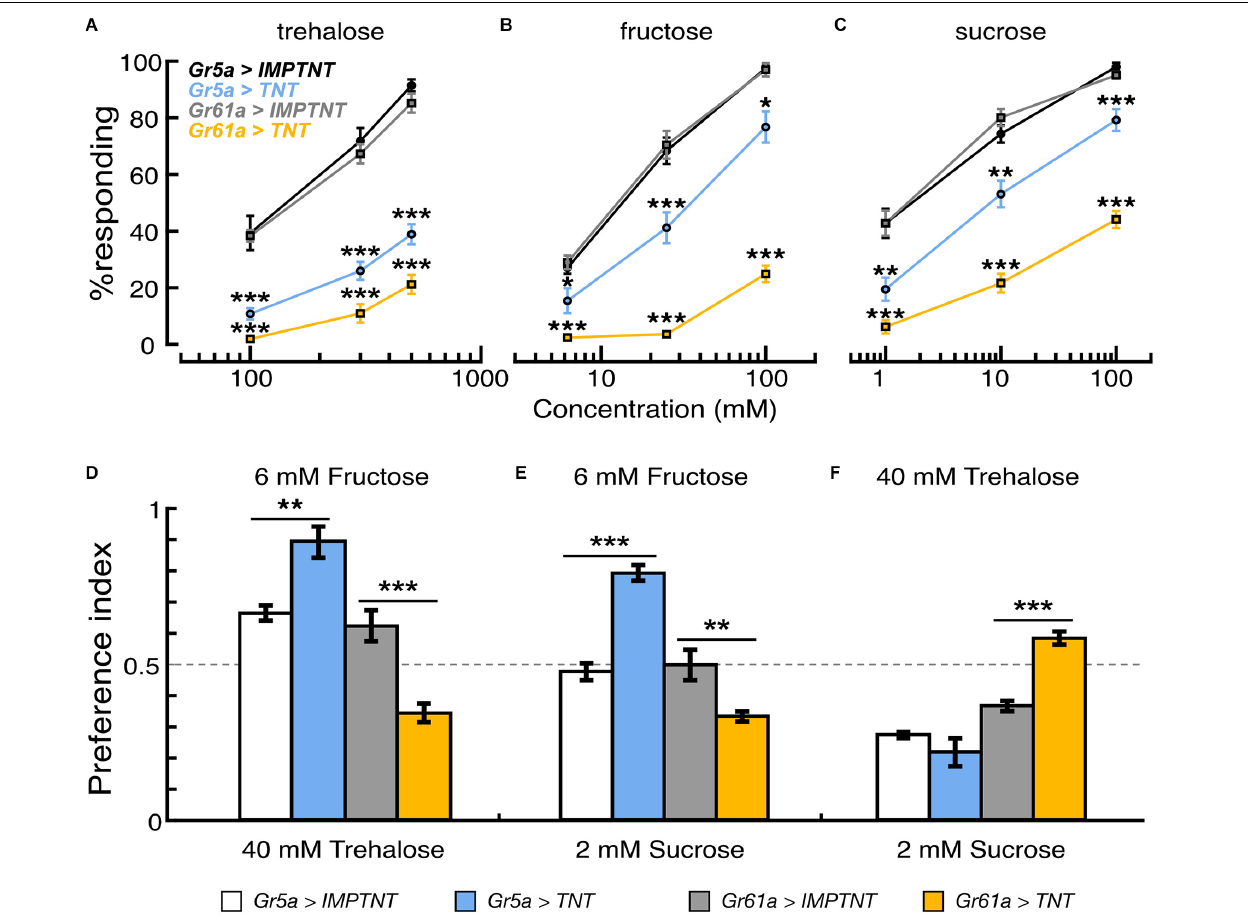
FIGURE 4 | Effect of population-specific blocking of sugar GRNs on feeding reflex and sugar preference. (A–C) Proportion of flies that showed proboscis extension reflex to tarsal stimulation with trehalose, fructose, and sucrose solutions in flies where synaptic transmission of Gr5a+ or Gr61a+ GRNs are blocked by ectopic expression of TNT. PER responses are shown as the average for those flies that responded in seven to nine experiments. In each experiment, 20–25 flies were used. (D–F) Feeding preferences in response to different combinations of sugar solutions. In each panel, scores are indicated as the average feeding preference for the solutions indicated on the top of the panel. Error bars indicate SEM. * p < 0.05; ** p < 0.01; *** p < 0.001 by U